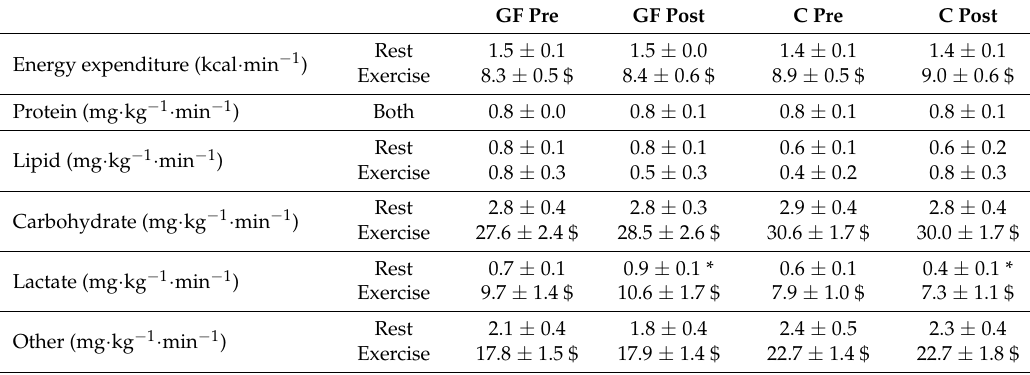
Table 3. Fuel Selection in the Resting and Exercise Periods of Metabolic Evaluations. GF Pre GF Post C Pre C